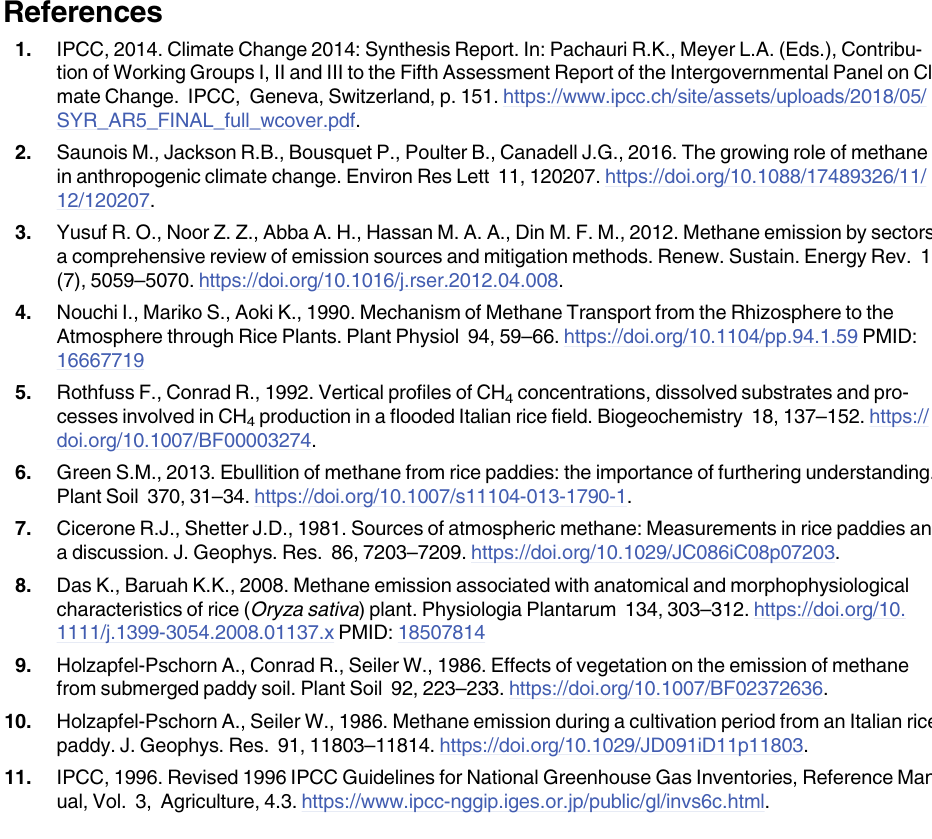
S2 Fig. Changes in plant growth characteristics during rice cropping season. S3 Fig. Static chamber installation and rice plant growth inside the closed chamber. S1 Table. The maximum plant volumes and growth characteristics with statistical signifi- cance between rice cultivars. S1 Data. Changes in CH emission rates (mg m -2 hr -1 ) which were calculated without con- 4 sidering biomass volume inside chamber during rice cropping